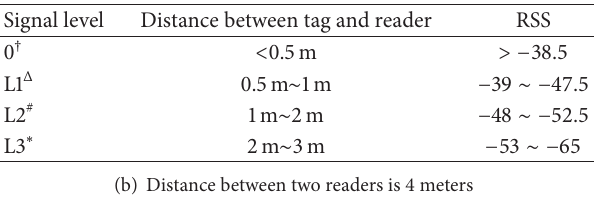
Table 4: The signal strength matrix under different distances between two